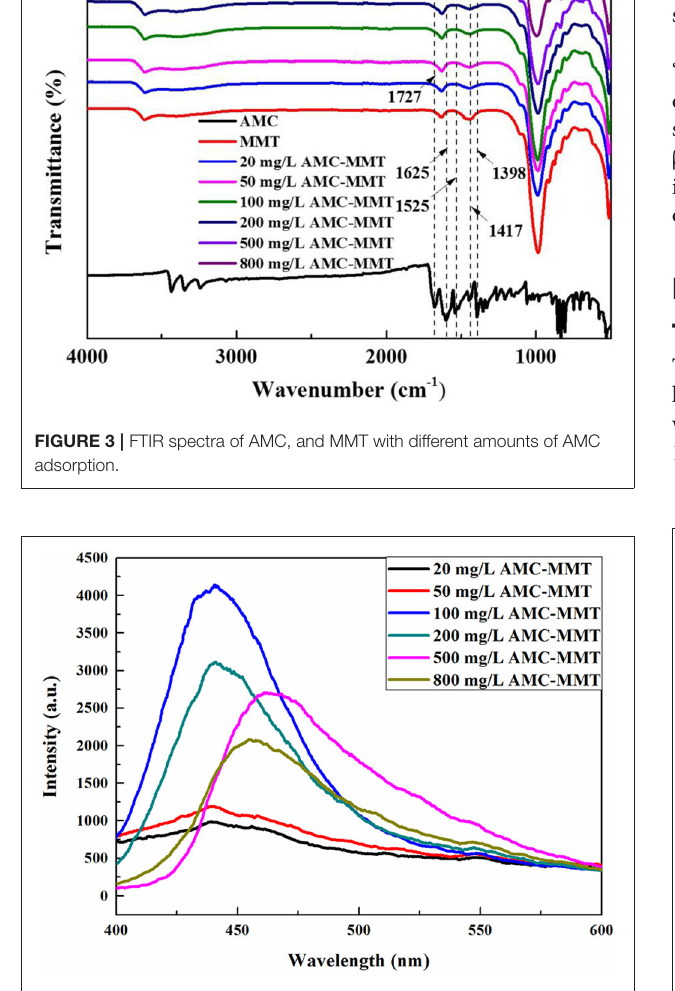
FIGURE 4 | Fluorescence spectra of AMC/MMT was Influenced by initial concentrations of